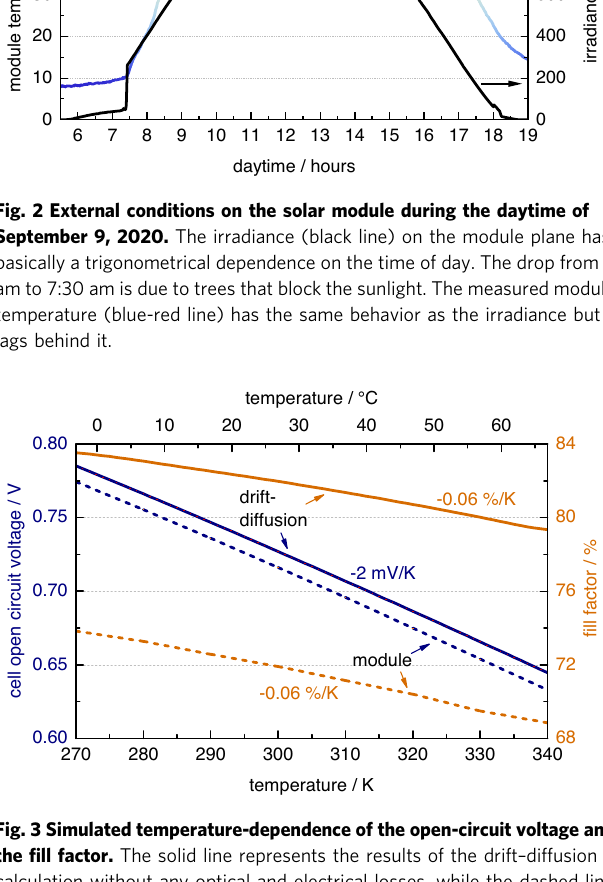
Fig. 3 Simulated temperature-dependence of the open-circuit voltage and the fi ll factor. The solid line represents the results of the drift – diffusion calculation without any optical and electrical losses, while the dashed line shows the overall module behavior. The rising temperature increases the intrinsic carrier concentration and decreases the band gap, which leads to the observed decreasing behavior of the open circuit voltage and the fi ll factor. The temperature dependence of the short circuit current density and power conversion ef fi ciency can be found in Supplementary Note 3. Applying meteorological data to the model . In order to simulate the daily yield of the module, the incoming irradiance and the module temperature (measured on the rear side of the module) need to be considered. Their course over the day can be seen in Fig. 2. We chose September 9, 2020 as a sample day because it was a clear day with no clouds. The dip at the left of the irradiance graph (black line) at half past 7 arises from locally present trees that cover the low sun at low altitudes in the morning. The module temperature (blue – red line) roughly follows the behavior of the irradiance with a certain delay due to heating.